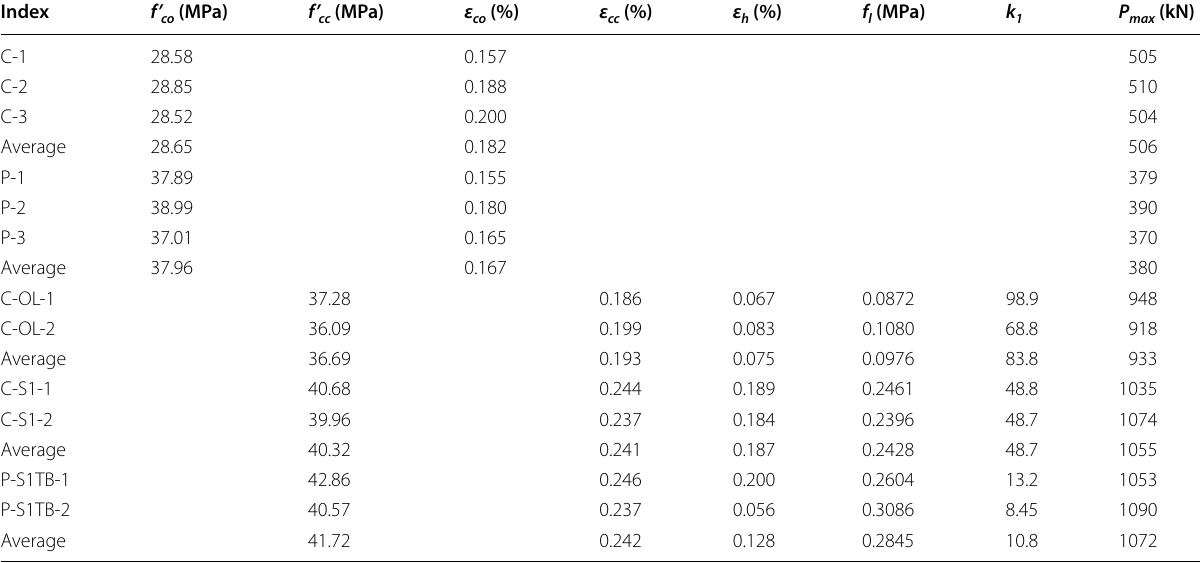
Table 7 Summary of test results: columns confinement by C-FRCM